Question: Express in one sentence what the figure is showing.
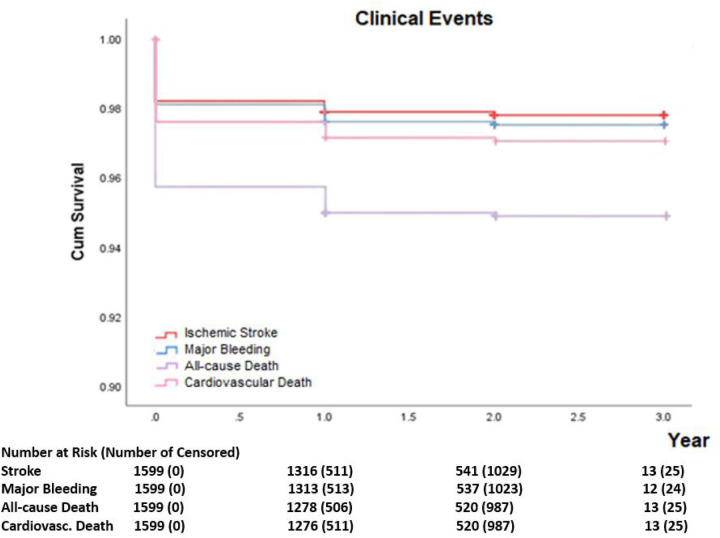
Answer: Kaplan–Meier curve of clinical events (ischemic stroke, major bleeding, cardiovascular- and all-cause death).